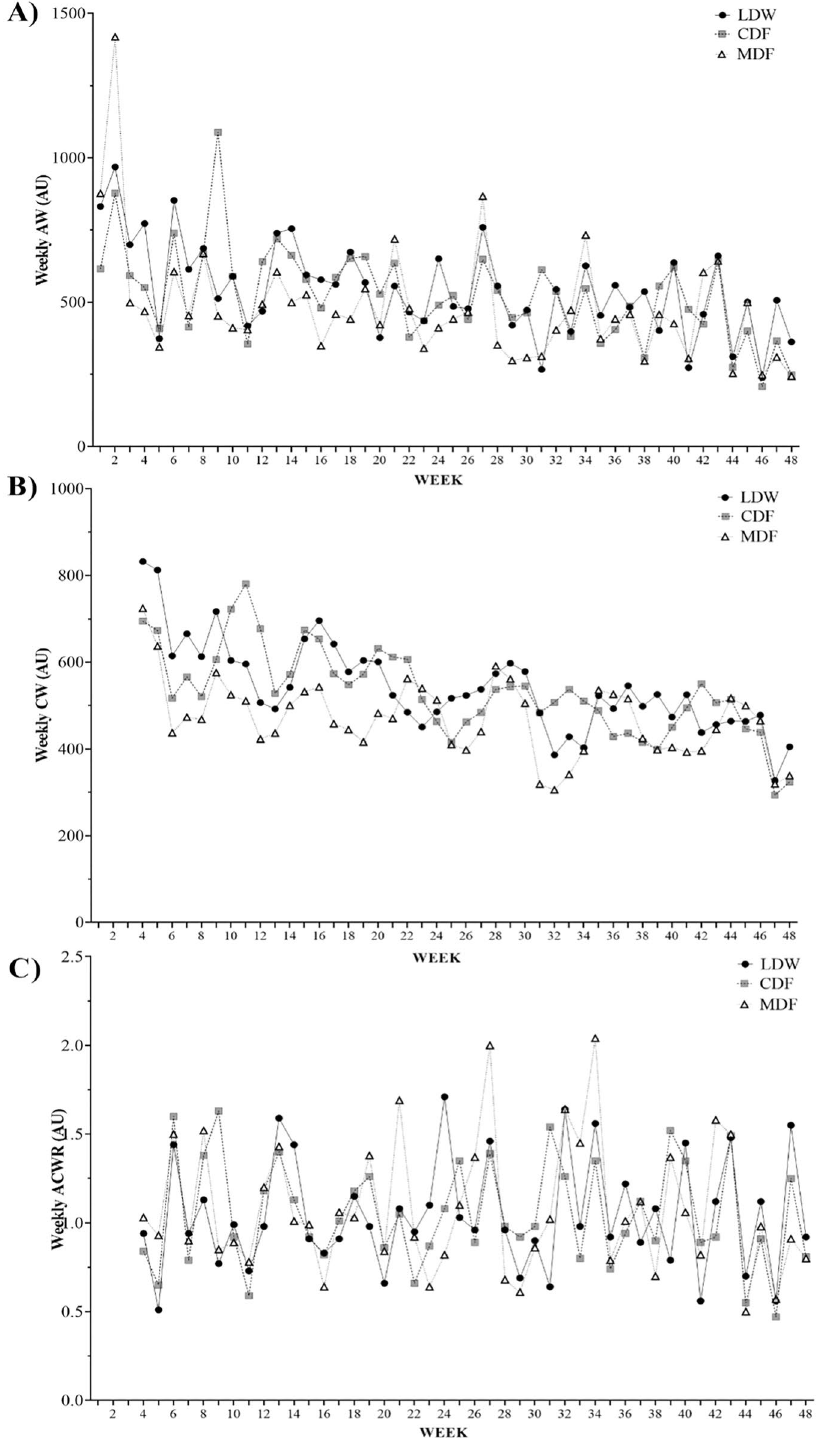
Figure 1. Overall vision of the ( A ) Weekly AW; ( B ) Weekly CW. ( C ) Weekly ACWR, variations across the full season by play